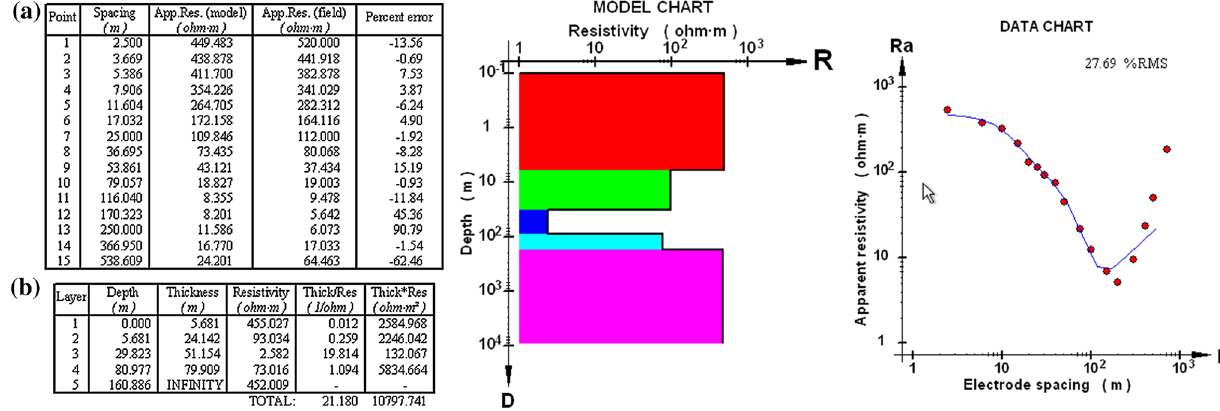
Fig. 4 Forward modeling (Tables a, b and Charts) for model VES6 model in comparison with data VES6 data-Schlumberger array at VES6